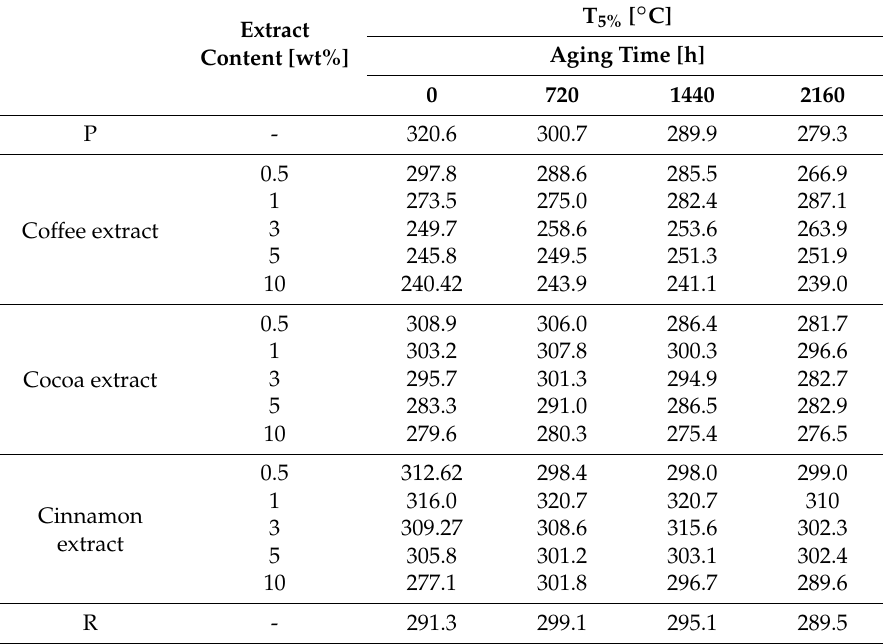
Table 2. Thermogravimetric test